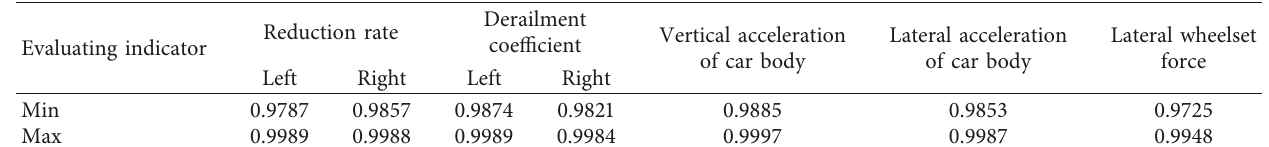
Table 3: Probabilities of limit values of the vehicle-safety evaluation